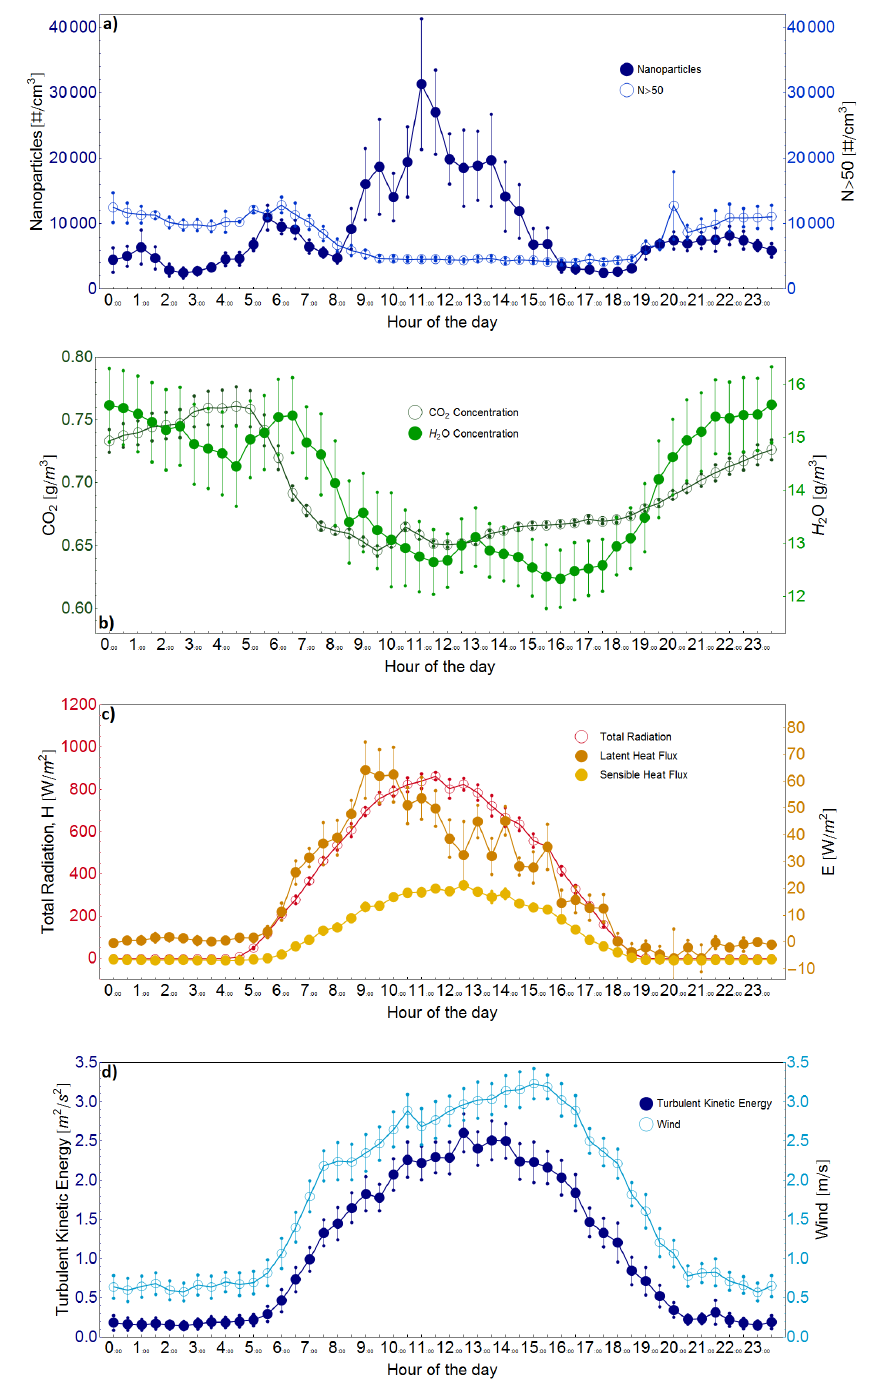
Figure 3. Average daily concentration patterns of nanoparticles and particles larger than 50 nm ( a ); H O/CO concentrations ( b ); solar radiation, sensible heat flux H and latent 2 2 heat flux E ( c ); wind velocity and turbulent kinetic energy ( d ). Vertical bars represent standard